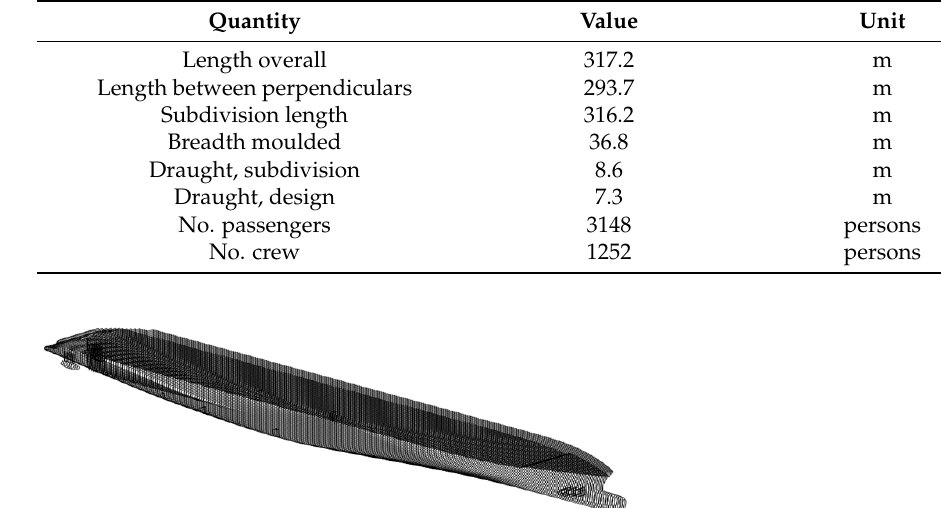
Table 4. General particulars for cruise ship C1.